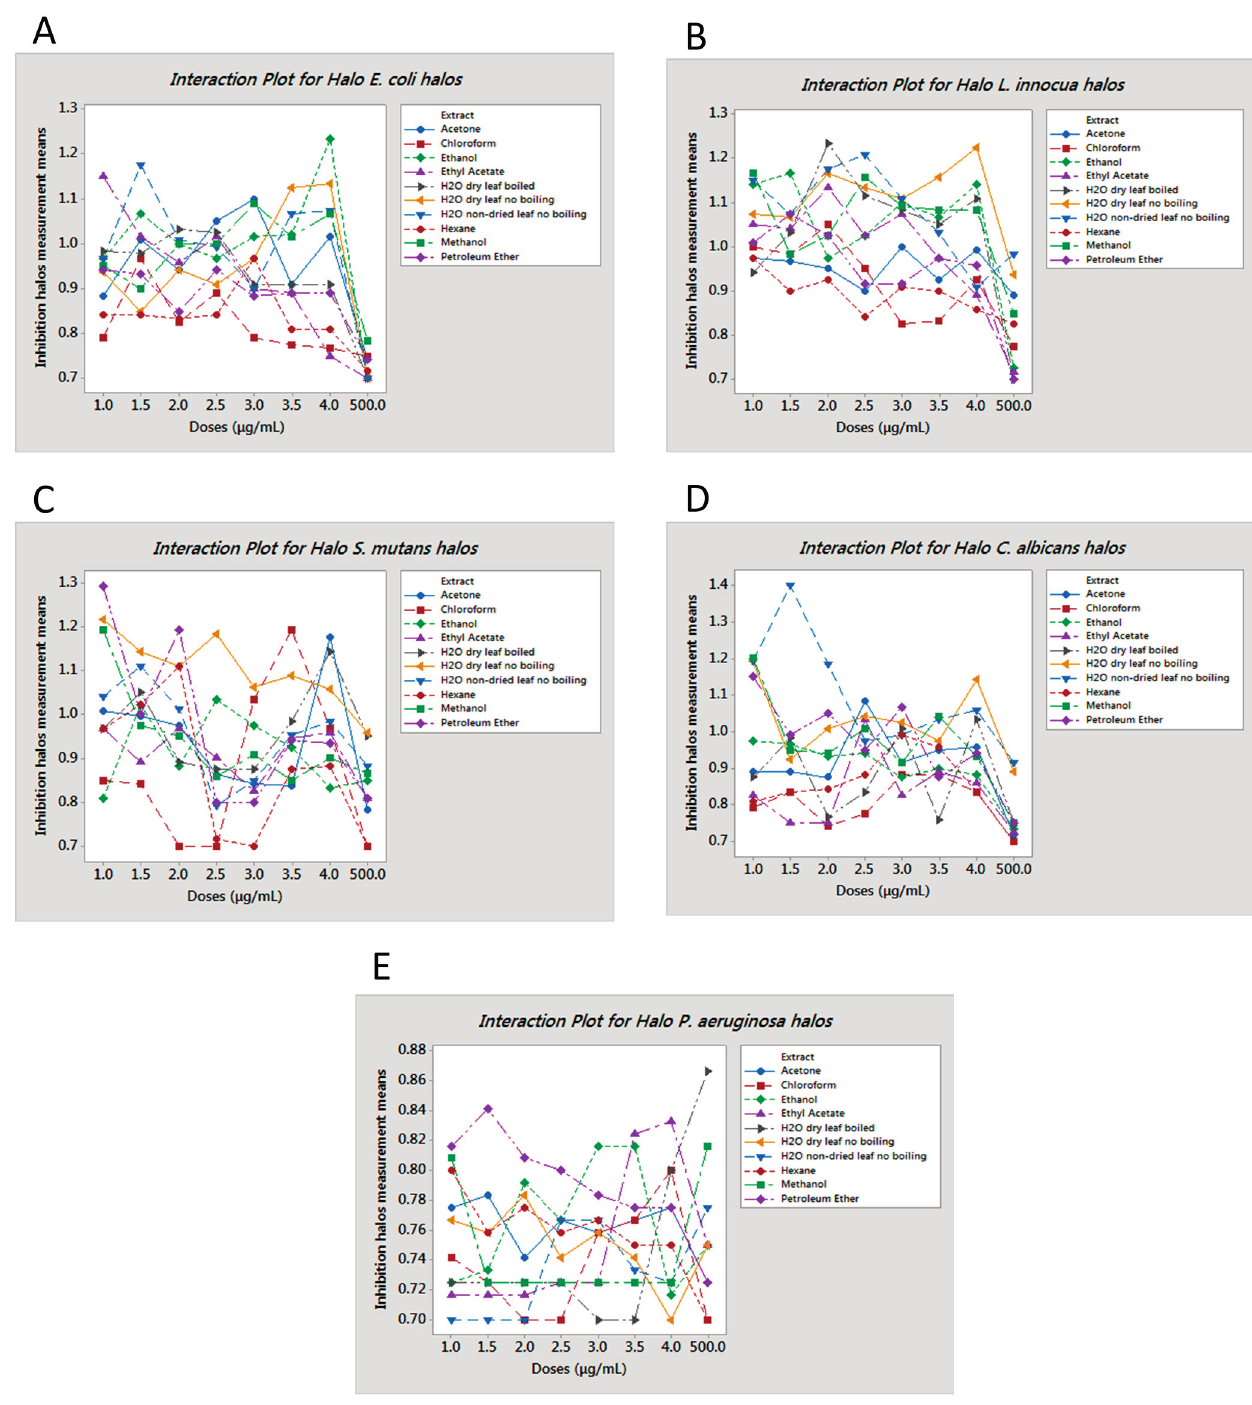
Figure 1. Interaction halo plots, ( A ) E. coli ; ( B ) L. innocua ; ( C ) S. mutans ; ( D ) C. albicans ; and ( E ) P. aeruginosa . Paper discs were 0.7 cm in diameter. Halo diameter in cm is given in the Y-axis vs. dose concentration in µg/mL in the X-axis. Inhibition was measured based on halo diameter in excess of 0.7 cm with higher peaks indicating the most active doses of extracts that produce inhibition halos of greater